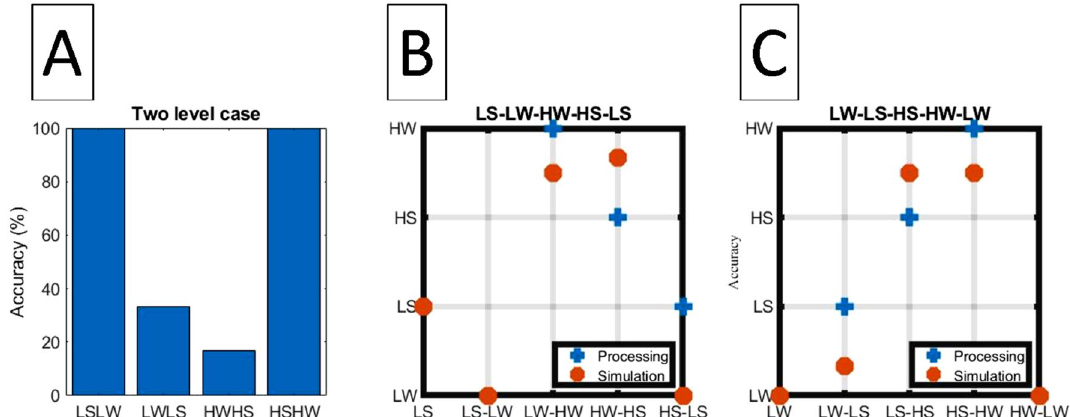
Figure 5. Plot ( A ) shows the accuracy in the case of two level transition from 5 testing samples. Compare with LSLW and HSHW that have a complete transition after detection by decision tree, the accuracy for LWLS and HWHS is lower. Several factors must be solved to obtain TM. Plots ( B ) and ( C ) show the circle case testing in Fig. 4B.